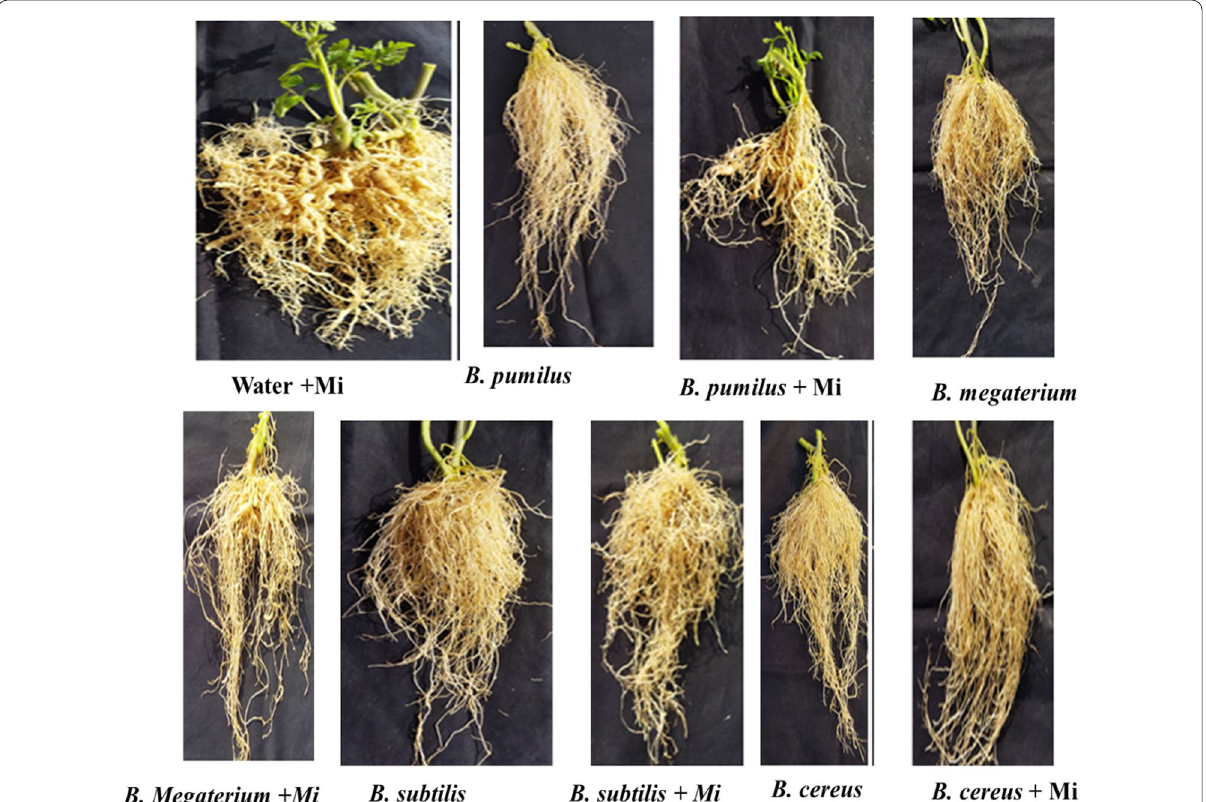
Fig. 3 Effect of rhizobacteria on root galls and root growth of tomato cv Pusa Ruby infected with Meloidogyne incognita